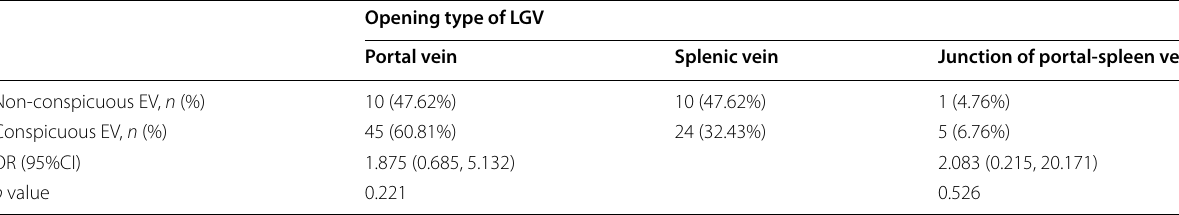
EV: esophageal varices, OR: odds ratio, CI: confidence interval